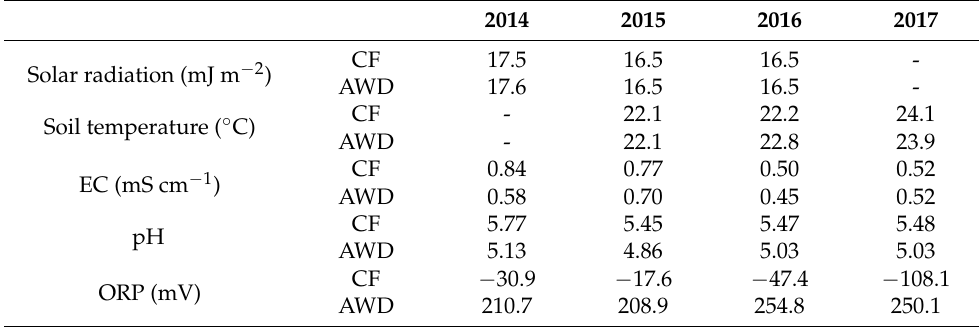
Table 1. Average solar radiation, soil temperature, electrical conductivity (EC), pH, and oxidation- reduction potential (ORP) from transplanting time to heading stage under continuous flooding (CF) and alternate wetting and drying (AWD), in 2014, 2015, 2016, and